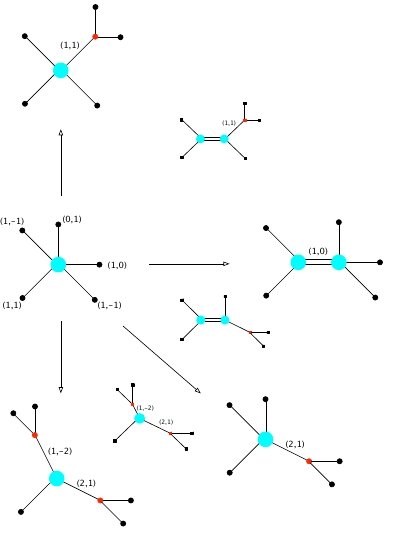
Figure 2 . The 5-brane webs corresponding to the phases of tyhe E 2 theory in figure